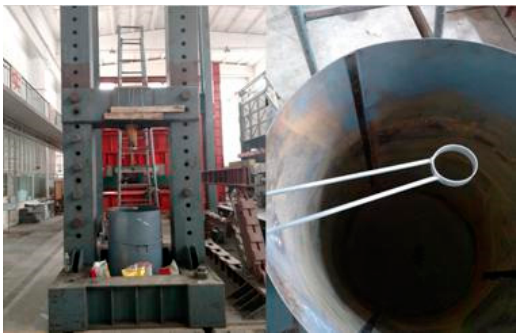
Figure 2. Model bucket and loading unit.